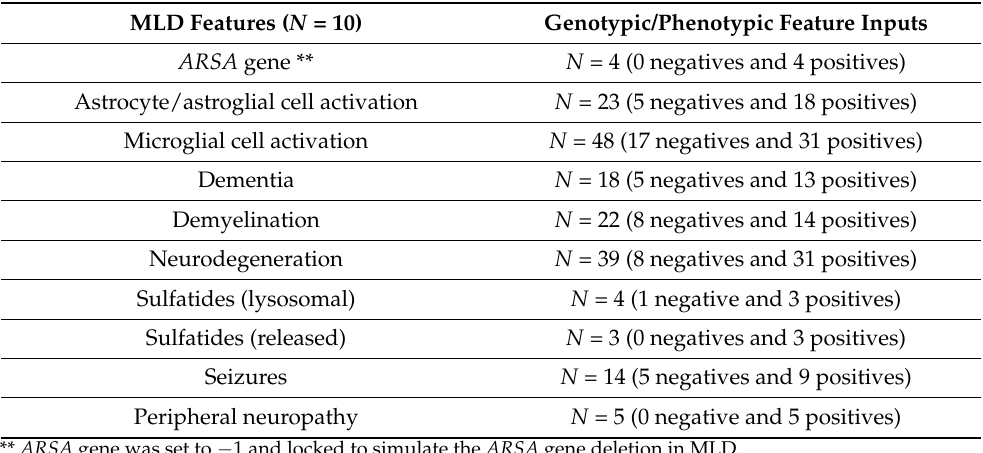
Table 2. Metachromatic leukodystrophy (MLD) feature